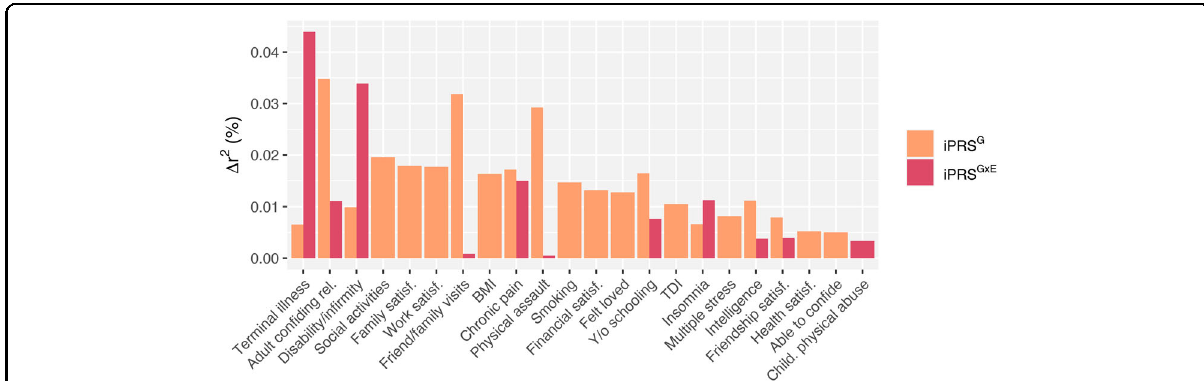
Fig. 2 Prediction accuracy of interaction-based polygenic risk scores. Interaction-based polygenic risk scores (iPRS) were computed for an independent subset of 10,000 individuals, using the sum of risk alleles weighted by the SNP betas and the environment. For the iPRS GxE s the SNP- environment interaction beta was used as a weight, whereas for the iPRS G s, the SNP main effect betas from GWAS was used instead. The Y -axis re fl ects the Δ r 2 , i.e., the difference in adjusted r 2 between models containing the iPRSs and all covariates to a covariates-only model. The differences in model fi t between the full model and the covariate only model were evaluated using anova in R. Only environments with a Δ r 2 greater than zero are shown; none of the iPRS G s or iPRS GxE s explained a signi fi cant proportion of variance in neuroticism beyond covariates ( p <